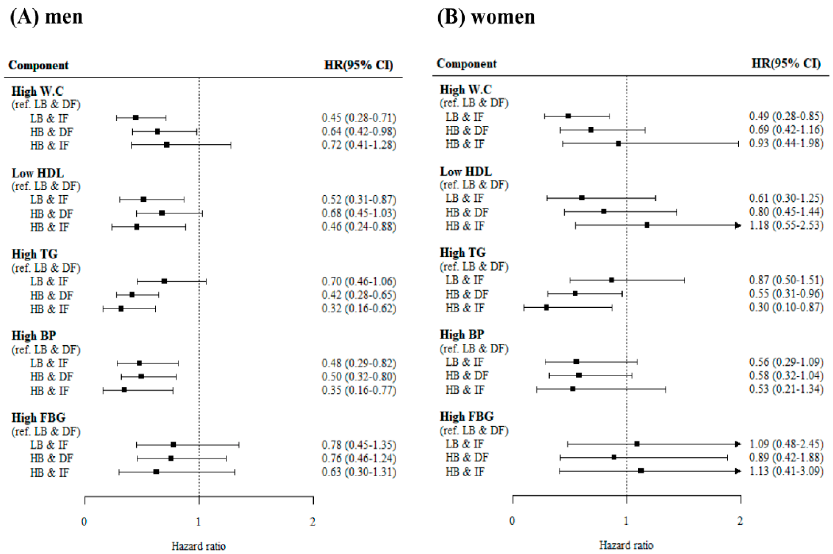
baseline and increased adiponectin during